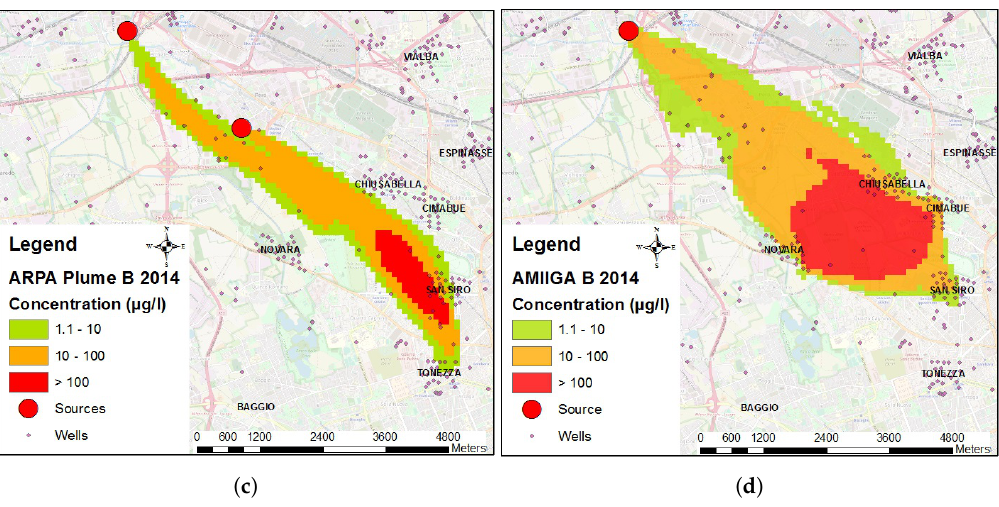
Figure 8. Comparisons between transport simulations in the Aquifer B carried out in ARPA Plume 2015 and AMIIGA 2018 (average concentration of layers from 3 to 9). Figures ( a , b ) represent 1989 (35 years of simulation) while figures ( c , d ) represent 2014.